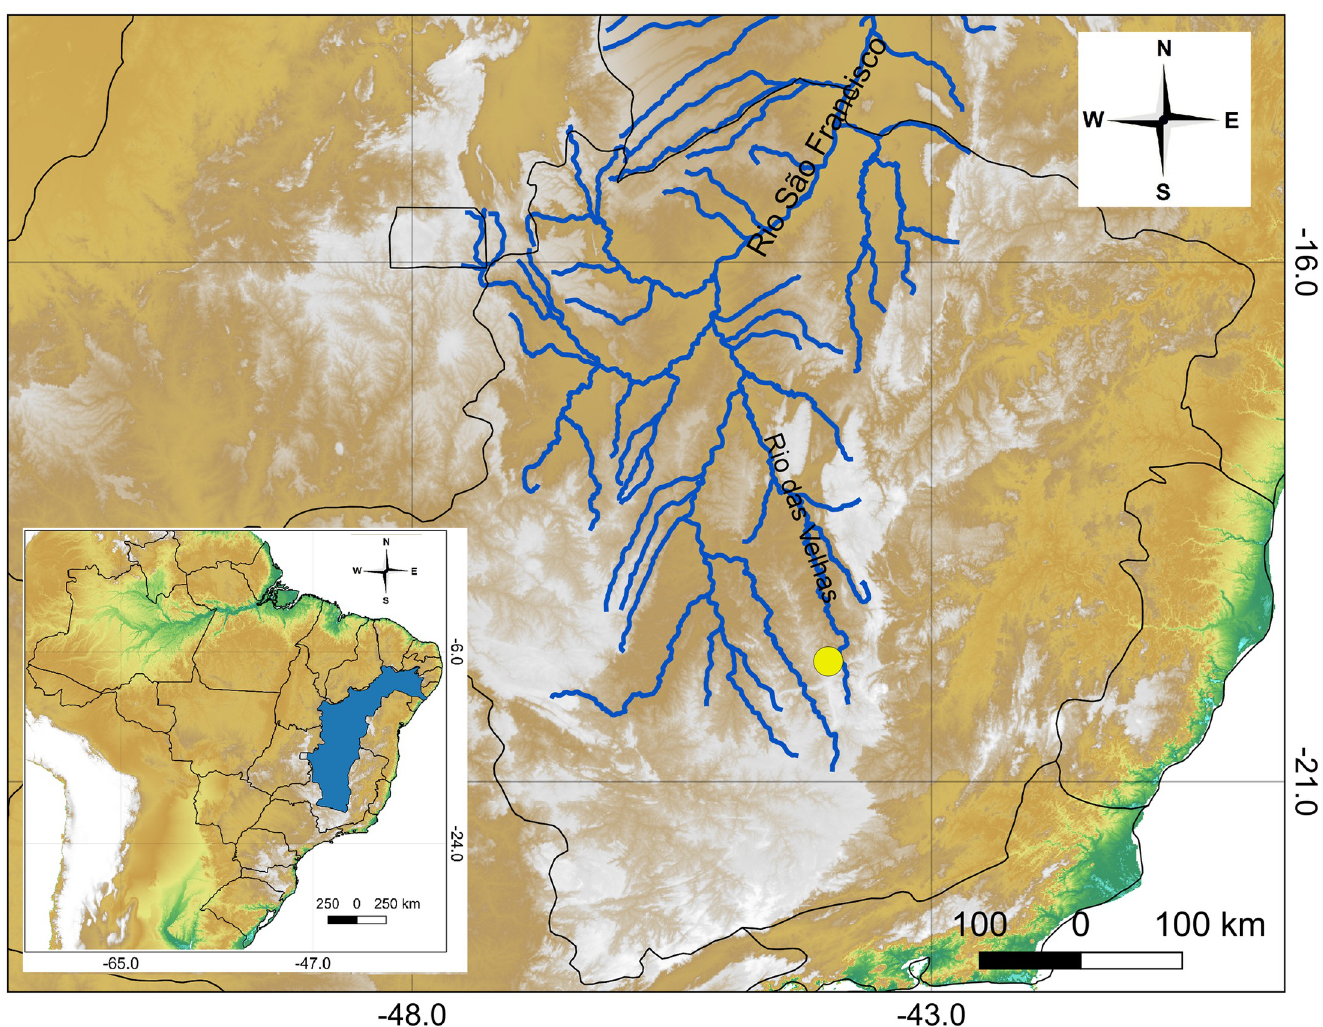
Fig 4. Geographical distribution of Hypostomus subcarinatus ; (yellow circle = Lagoa da Pampulha). Blue shaded area and lines are the Rio S ã o Francisco basin.